Question: Write a caption explaining this figure to a reader.
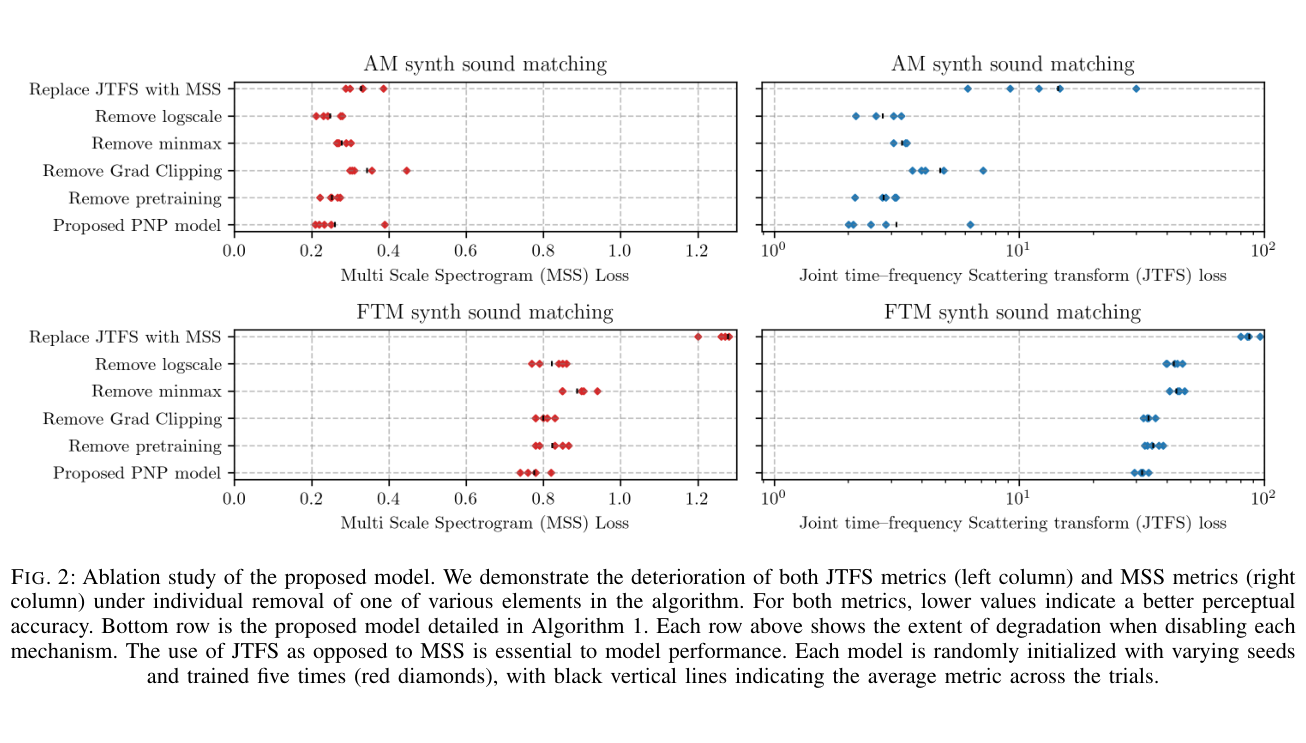
Answer: that both scaling operations help ease the retrieval. For both AM/FM arppegiator and FTM drum synthesizer, min–max scaling contributes more to the improvement of model convergence than does logarithmic transformation. Even though removing logarithmic transformation results in inad- equate scaling that further deviates from linear correlation with perceptual difference, the min–max scaling still con- fines the parameter range and in turn the prediction error. On the contrary, removing min–max scaling while keeping logarithmic transformation induces drastic parameter ranges and poses serious challenge in training the penultimate layer of f W, even if the logarithmic transformation reduces that range discrepancy. This potentially explains the relatively larger degradation in removing min–max scaling when retrieving from FTM drum sounds. 4) Effect of optimizer: The addition of weight decay and gradient clipping has greatly improved the convergence across all models, reducing both